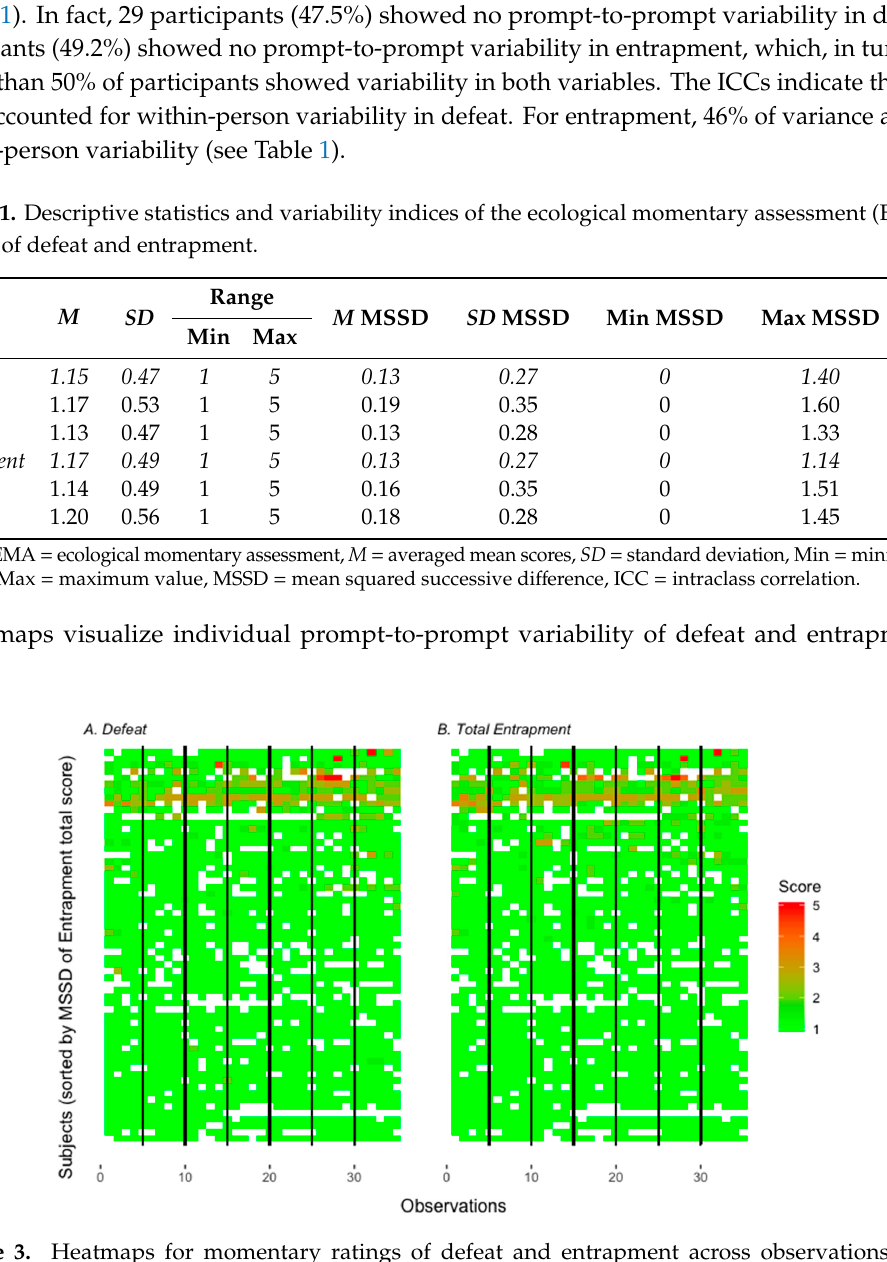
Figure 3. Heatmaps for momentary ratings of defeat and entrapment across observations and participants. Ratings of momentary defeat and entrapment are coded by color. Green symbolizes low momentary ratings and red symbolizes high momentary ratings of the construct. Missings are coded white. In each heatmap, one row represents one participant and one square represents one momentary rating. On the x-axis, vertical lines separate the days of the assessments (days 1–7). Additionally, numbers in steps of ten (0, 10, 20, 30) indicate the number of assessments (total 35 assessments). On the y-axis, participants are sorted by their MSSD score of total entrapment (participants with high entrapment MSSD scores are represented in the upper portion of the heatmap and participants with low entrapment MSSD scores are represented in the lower portion of the heatmap). Momentary ratings of the represented variables vary within participants and across time, as is pictured here. Overall, the lower part of the heatmap is dominated by green, and red shades are mostly missing, meaning missing or very low levels of defeat and entrapment for many participants.